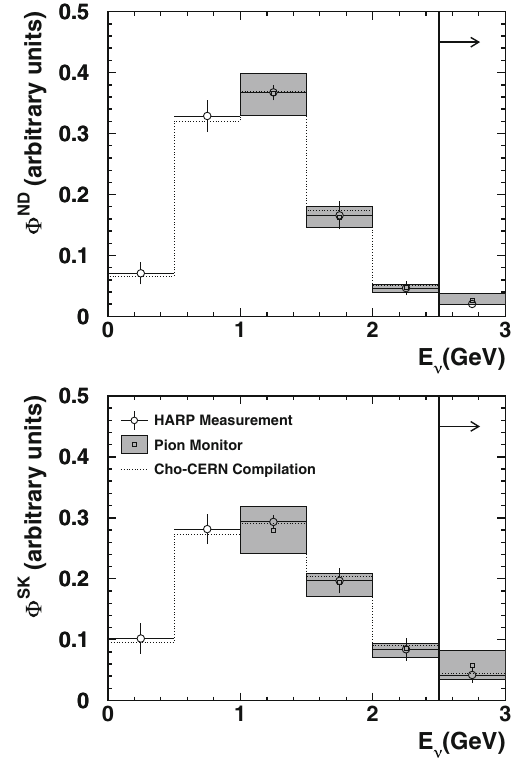
Fig. 19 Relatively-normalized muon neutrino flux predictions at the near (top) and far (bottom) detectors. The empty circles with error bars show the central values and shape-only errors based on the HARP π + production measurement, the empty squares with shaded error boxes show the central values and errors from the pion monitor (PIMON) measurement, and the dotted histograms show the central values from the Cho-CERN compilation of older (non-HARP) π + production data. The PIMON predictions are normalized such that the integrated fluxes above 1 GeV neutrino energy match the HARP ones, at both the near and far